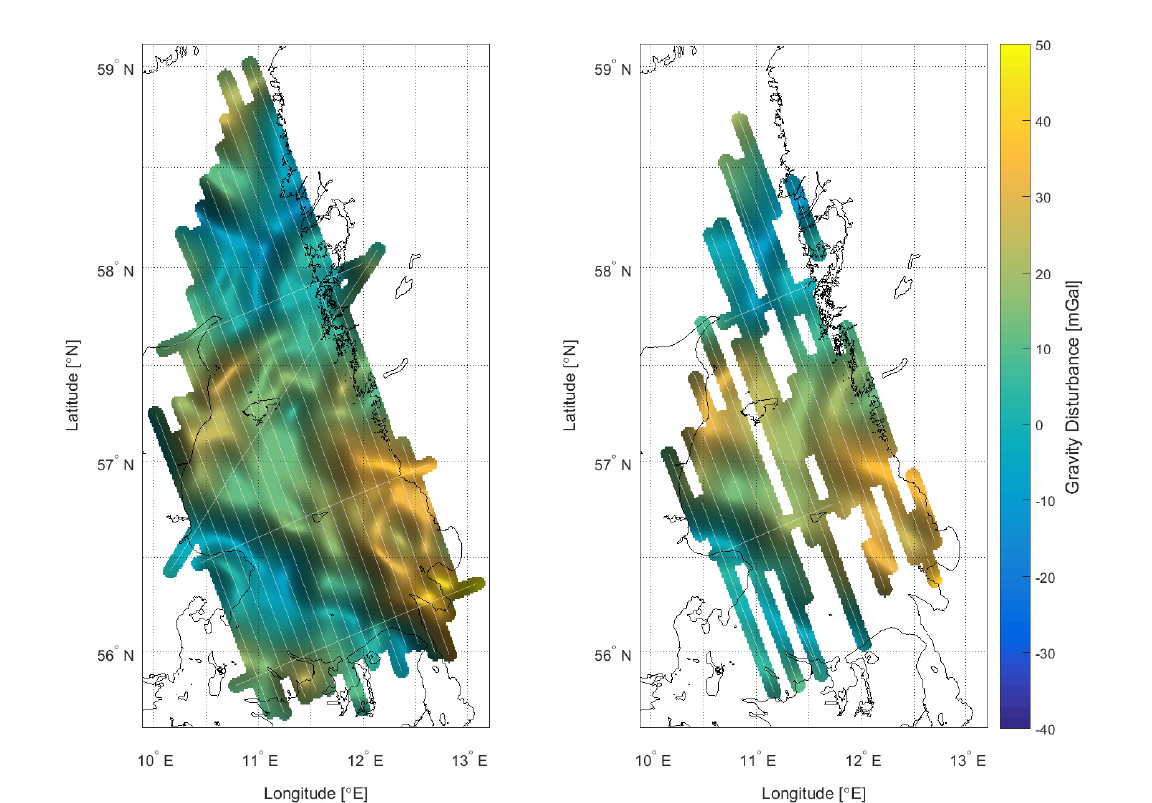
Figure 5. Gravity disturbance estimates from the survey. The line estimates are interpolated using collocation with a third-order Gauss-Markov model (Left): Estimates derived from the iMAR strapdown gravimeter; (Right): Estimates derived from the ZLS platform-stabilised